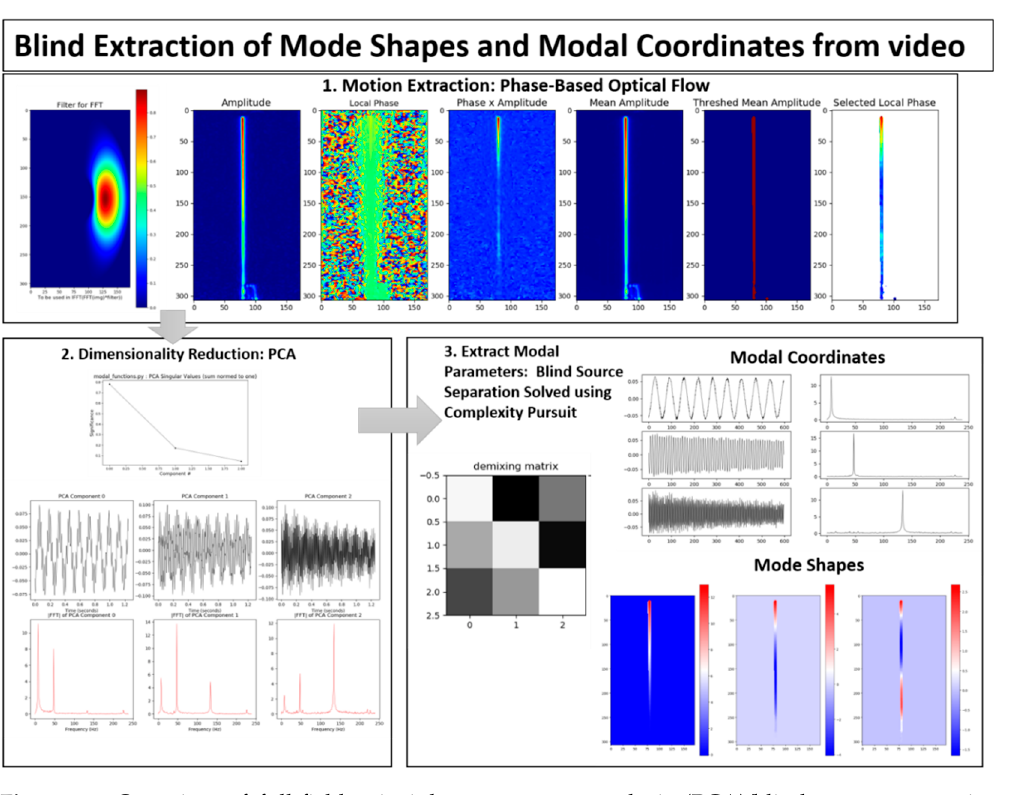
Figure 1. Overview of full-field principle components analysis (PCA)/blind source separation (BSS)-based blind source separation algorithm.